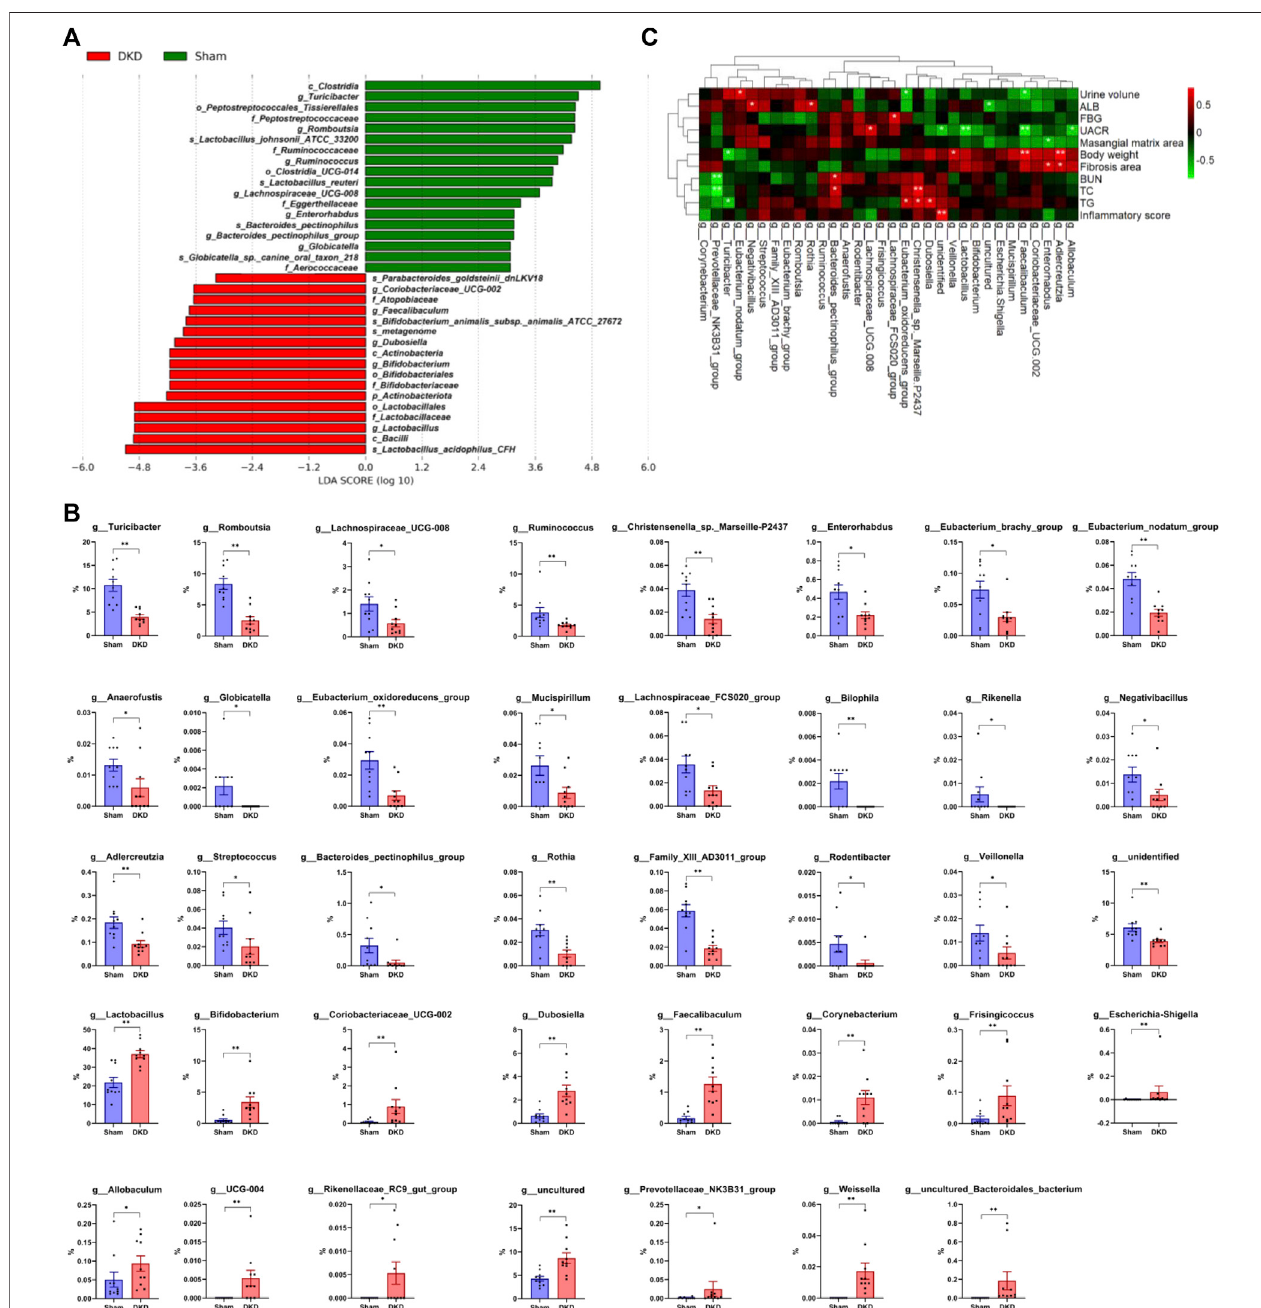
FIGURE6| DifferentialgutmicrobiomeinDKDratscomparedtoshamrats. (A) LDAscoreofthesigni fi cantlydiscriminanttaxabetweenthetwogroups(LDAscore > 3.0, Wilcoxon rank-sum test, p < 0.05). (B) Bar graphs of the signi fi cant differences in the relative abundance of 39 genera between sham and DKD rats selected by Wilcoxontestanalysisand p -value < 0.05.* p < 0.05,** p < 0.01,versusshamrats. (C) SpearmanrankcorrelationbetweenDKD-relatedbaseparametersanddifferential genera (selected from Wilcoxon rank-sum test, p < 0.05) displayed in heat map cluster analysis (* p < 0.05, ** p < 0.01).